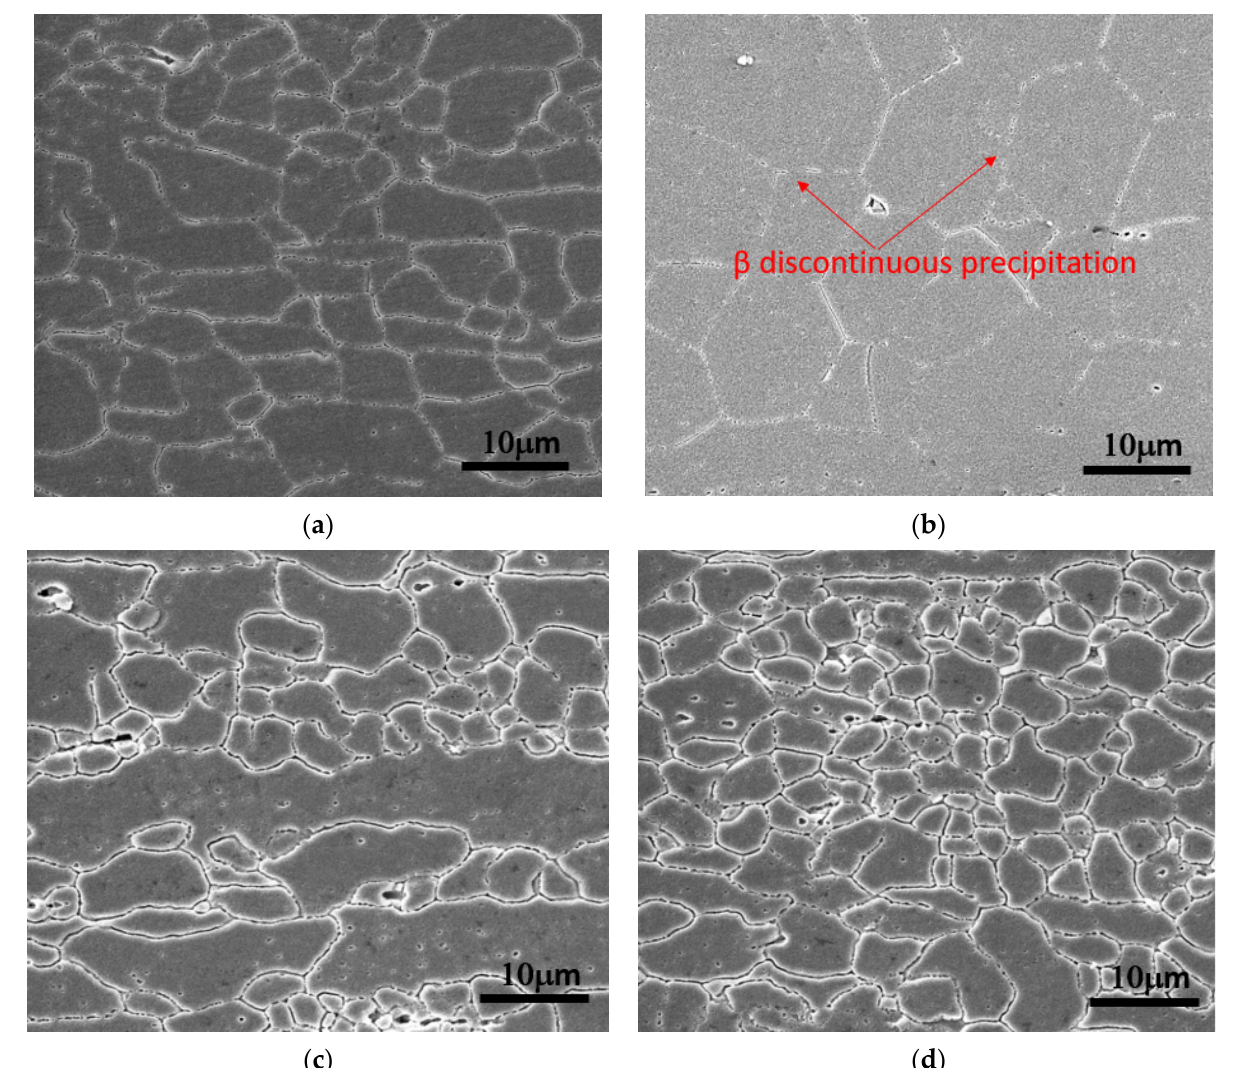
Figure 7. Precipitation morphology of β phase after sensitization treatment: ( a ) alloy B(0.1Zr) annealed at 350 °C; ( b ) alloy B(0.1Zr) annealed at 450 °C; ( c ) alloy C (0.05Sc) annealed at 350 °C; ( d ) alloy C(0.05Sc) annealed at 450 °C.